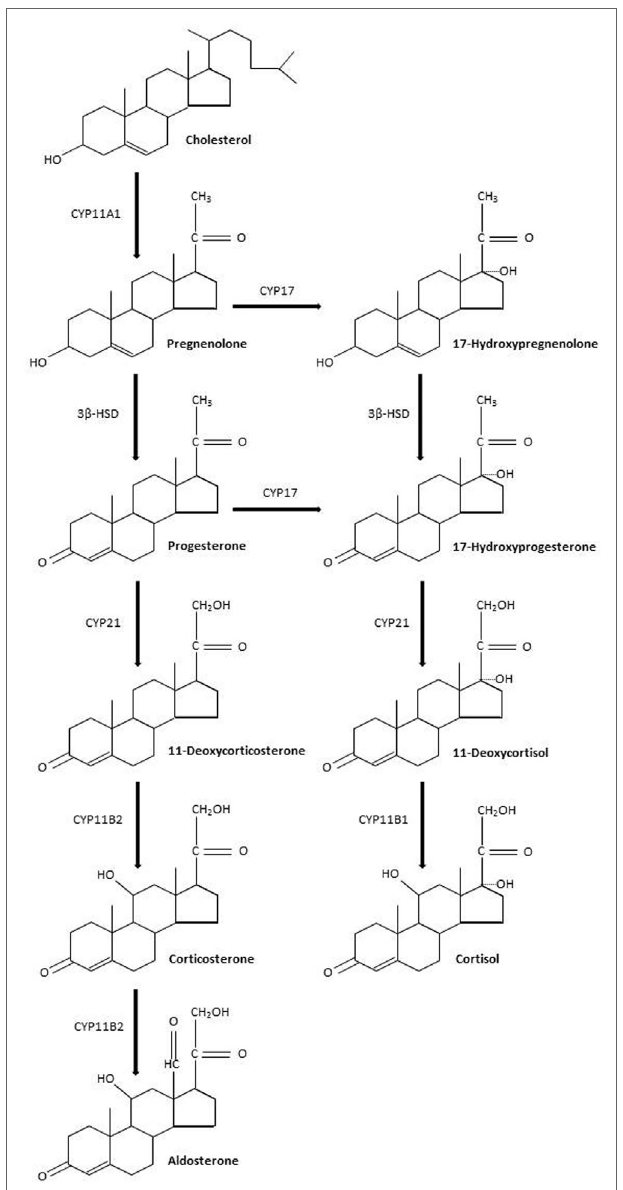
FigURe 1 | Corticosteroids biosynthesis. Abbreviations: CYP11A1, cholesterol desmolase; 3 β -HSD, 3 β hydroxysteroid dehydrogenase; CYP17, steroid 17 α -hydroxylase; CYP21, steroid 21-hydroxylase; CYP11B2, aldosterone synthase; CYP11B1, steroid 11 β -hydroxylase.